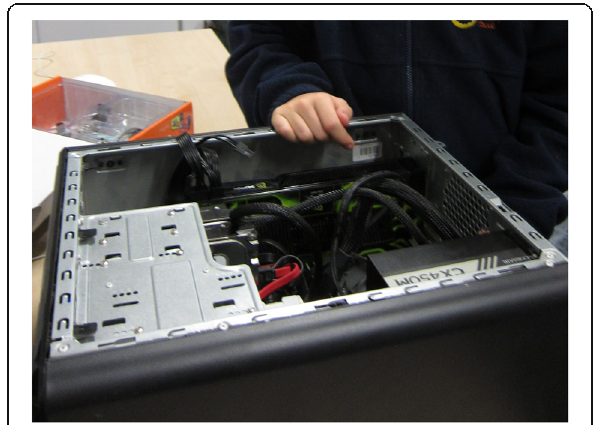
Fig. 1 Black-and-White ’ s home-built